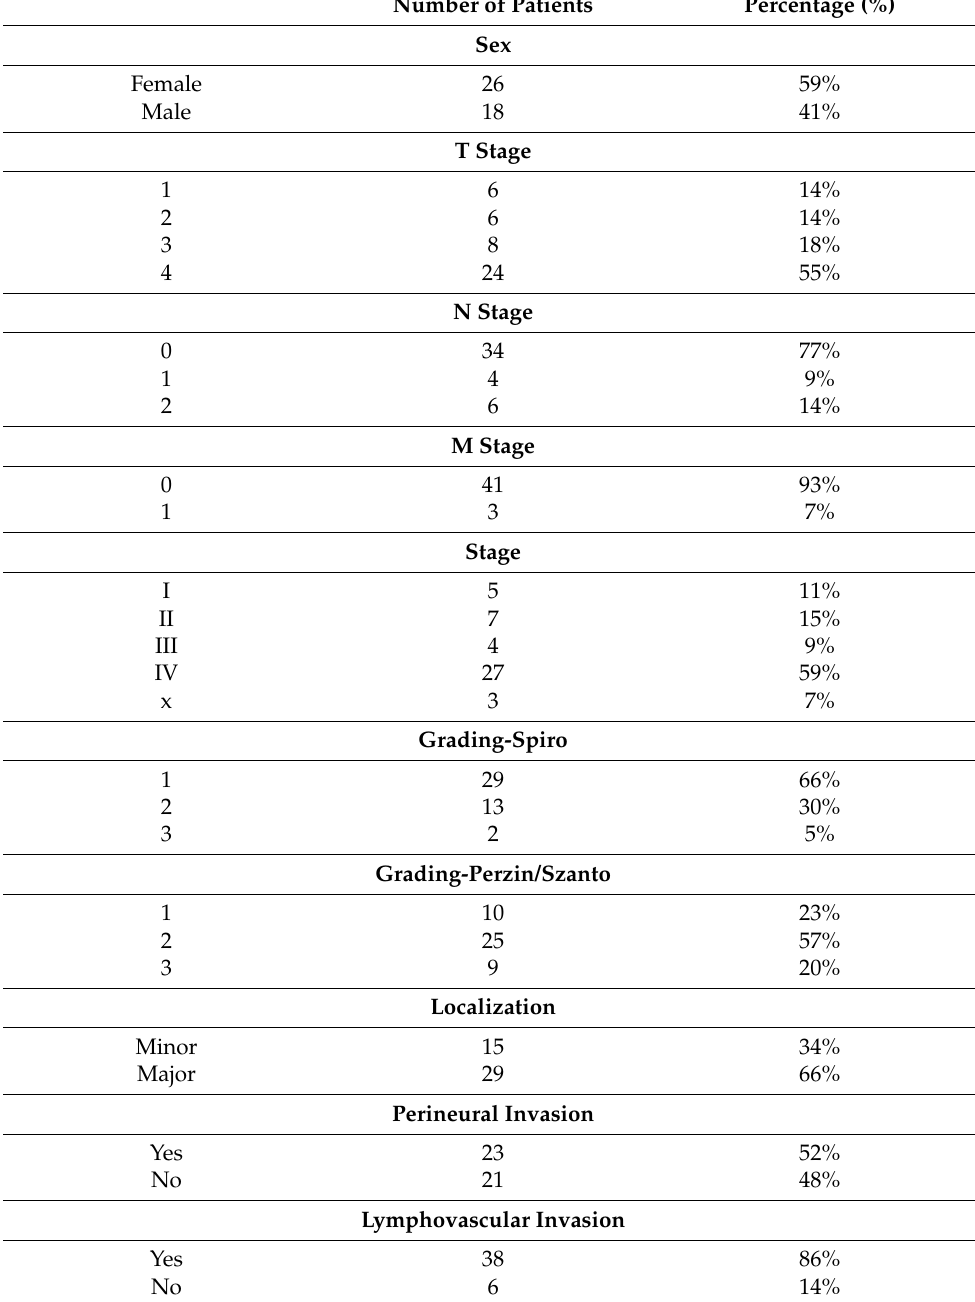
Table 1. Baseline patient characteristics of adenoid cystic carcinoma